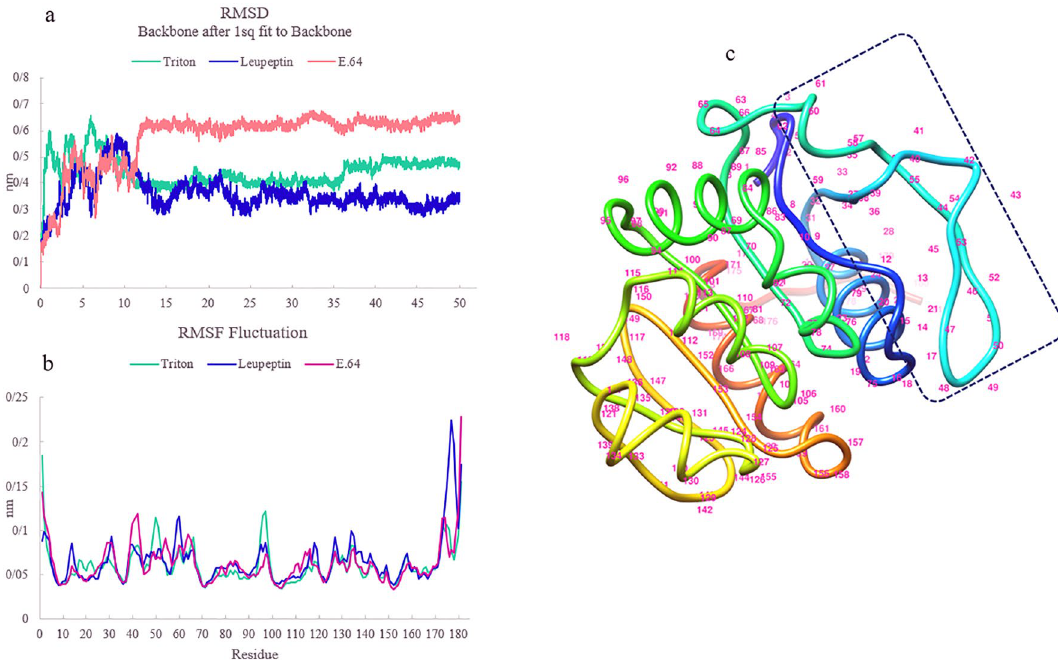
Figure 6. MD simulation of rEla cysteine protease in complex with Triton X-100, E.64 and Leupeptin. ( a ) RMSD graph, ( b ) RMSF graph and ( c ) The structure of flexible loop effective on activation/deactivation of rEla. The loop is located between two β-sheets and consists of residues from 39 to